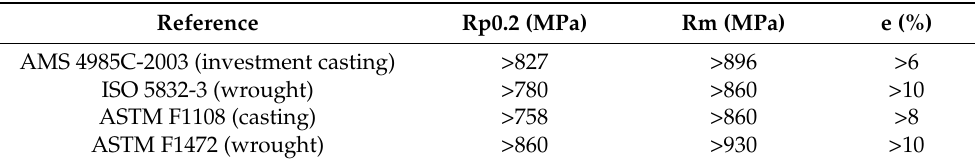
Table 5. Standards for casting and wrought parts for Ti6Al4V regarding tensile